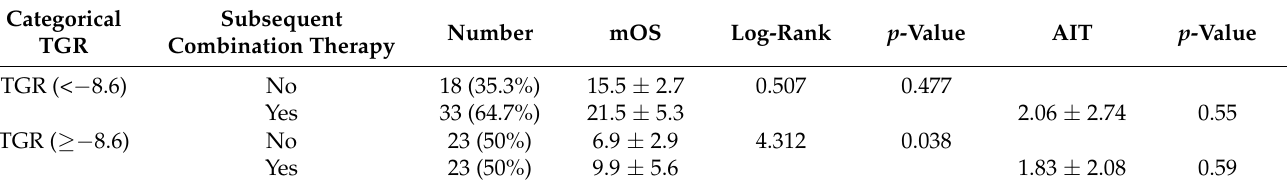
Table 3. Subgroup analysis of subsequent combination therapy (mean SD/N